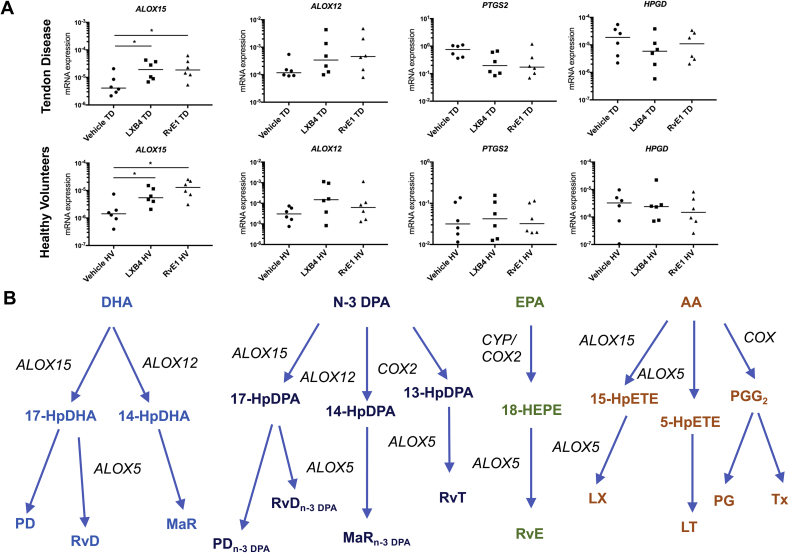
Biosynthesis of specialized proresolving mediators in tendon stromal cells. A: mRNA expression of enzymes implicated in the biosynthesis of specialized proresolving mediator (SPMs; ALOX15, ALOX12), inflammation-initiating eicosanoids (PTGS2), and the degradation of SPMs and inflammation-initiating eicosanoids (HPGD) in tendon stromal cells from patients with shoulder tendon tears and healthy volunteers (HVs). Incubation in lipoxin B4 (LXB4) significantly induces ALOX15 mRNA in both tendon disease (TD) and HV cells compared with respective vehicle controls. Incubation in resolvin E1 (RvE1) significantly induces ALOX15 mRNA in both TD and HV cells compared with respective vehicle controls. Gene expression is normalized to β-actin. B: Summary of lipid mediator biosynthetic pathways. Bars indicate median values. *P < 0.05 versus respective vehicle control. PD, protectin; RvT, 13-series resolvin; MaR, maresin; RvE, E-series resolvins; LX, lipoxins; LT, leukotrienes; PG, prostaglandins; Tx, thromboxane; ALOX, lipoxygenase; COX, cyclooxygenase; CYP, cytochrome P450.